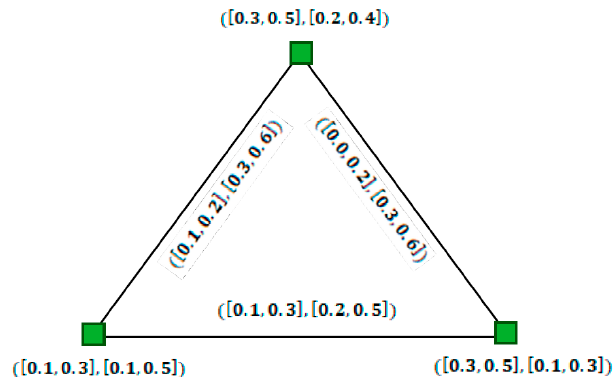
Figure 7. Interval-valued intuitionistic fuzzy graph.